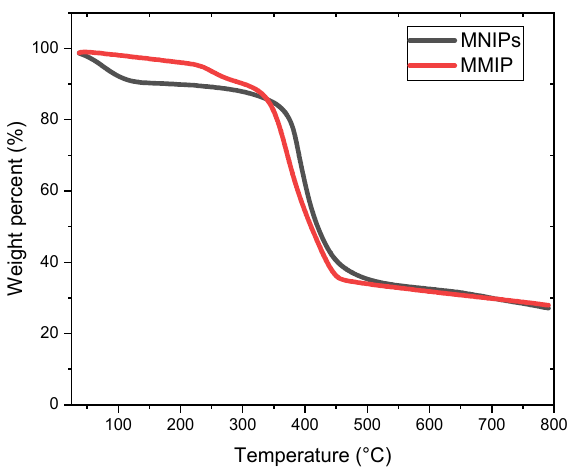
Figure 4. Thermogravimetric analysis plots of the MMIPs (black) and MNIPs (red) were obtained under a nitrogen atmosphere.